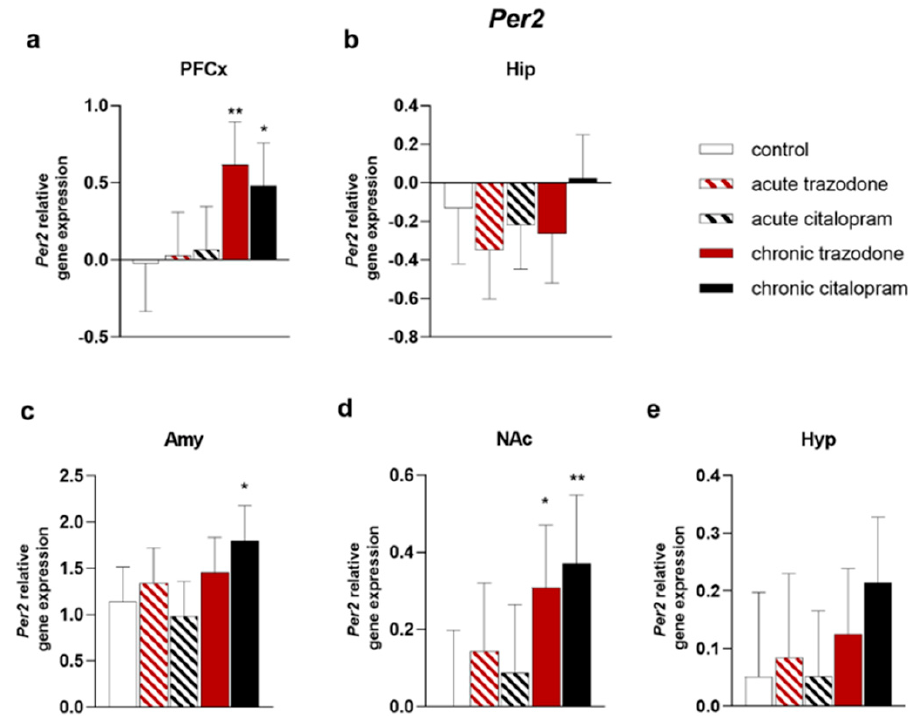
Figure 9. mRNA levels of Per2 in the PFCx ( a ), Hip ( b ), Amy ( c ), NAc ( d ), and Hyp ( e ) after acute or chronic treatment with trazodone, citalopram, or vehicle. The least square predicted means with 95% confidence intervals are plotted. Data were log-transformed when required to stabilise the variance and satisfy the parametric assumptions ( a , b , d , e ). **: p < 0.01; *: p < 0.05 in the Planned Comparison vs. control. n = 6/group.